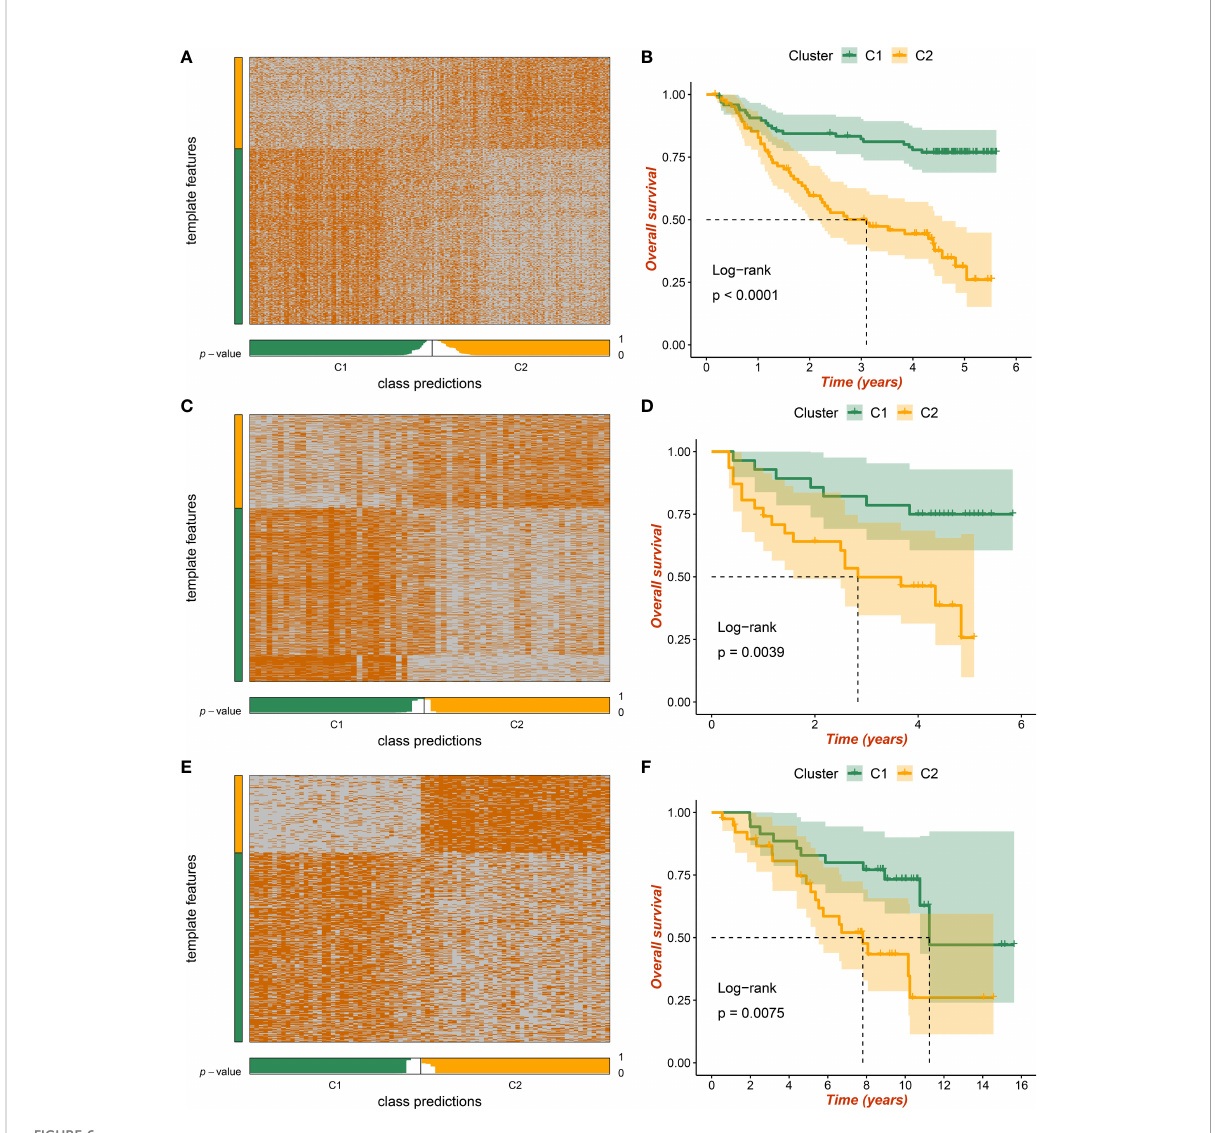
FIGURE 6 The validation of necroptosis subtypes by nearest template prediction (NTP) approach. (A) Validation of two heterogeneous necroptosis subtypes based on the nearest template prediction (NTP) analysis in GSE14520 dataset. (B) Kaplan – Meier curves of overall survival (OS) according to the necroptosis subtypes in GSE14520 dataset. (C) Validation of two heterogeneous necroptosis subtypes based on the NTP analysis in GSE116174 dataset. (D) Kaplan – Meier curves of OS according to the necroptosis subtypes in GSE116174 dataset. (E) Validation of two heterogeneous necroptosis subtypes based on the NTP analysis in GSE10141 dataset. (F) Kaplan – Meier curves of OS according to the necroptosis subtypes in GSE10141